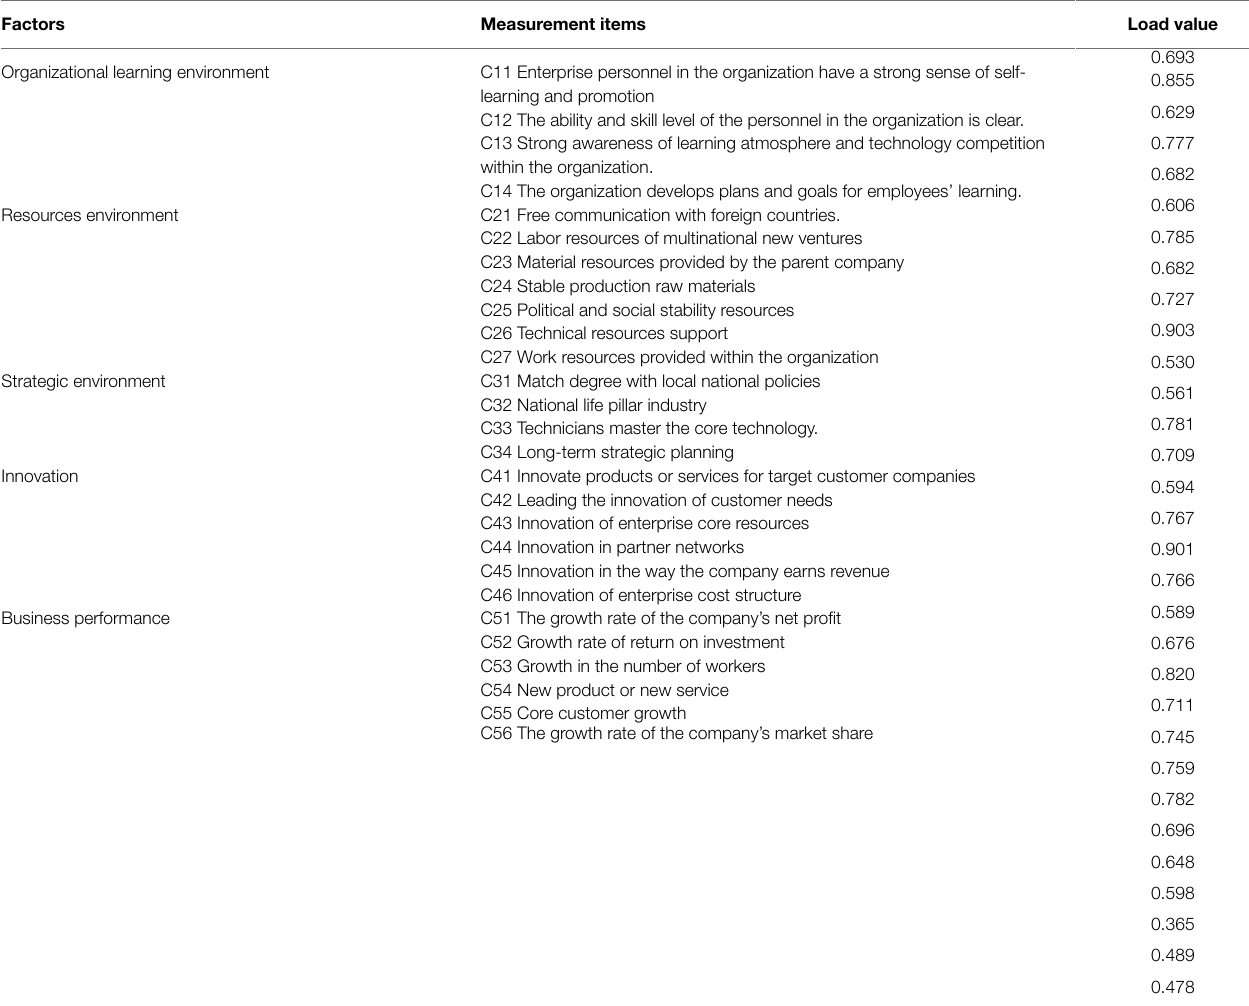
TABLE 1 | Variable factors and measurement